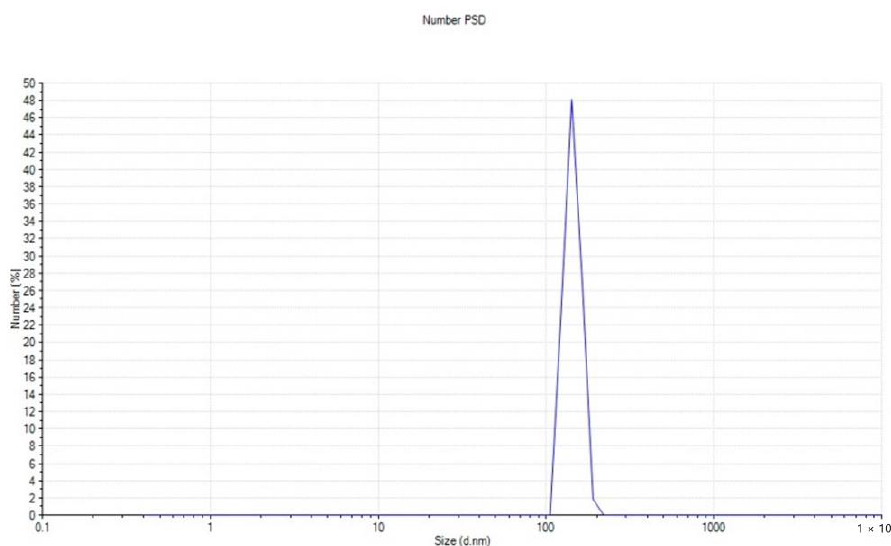
Figure 7. Particle size distribution of ZnO NPs from Lentinula edodes .